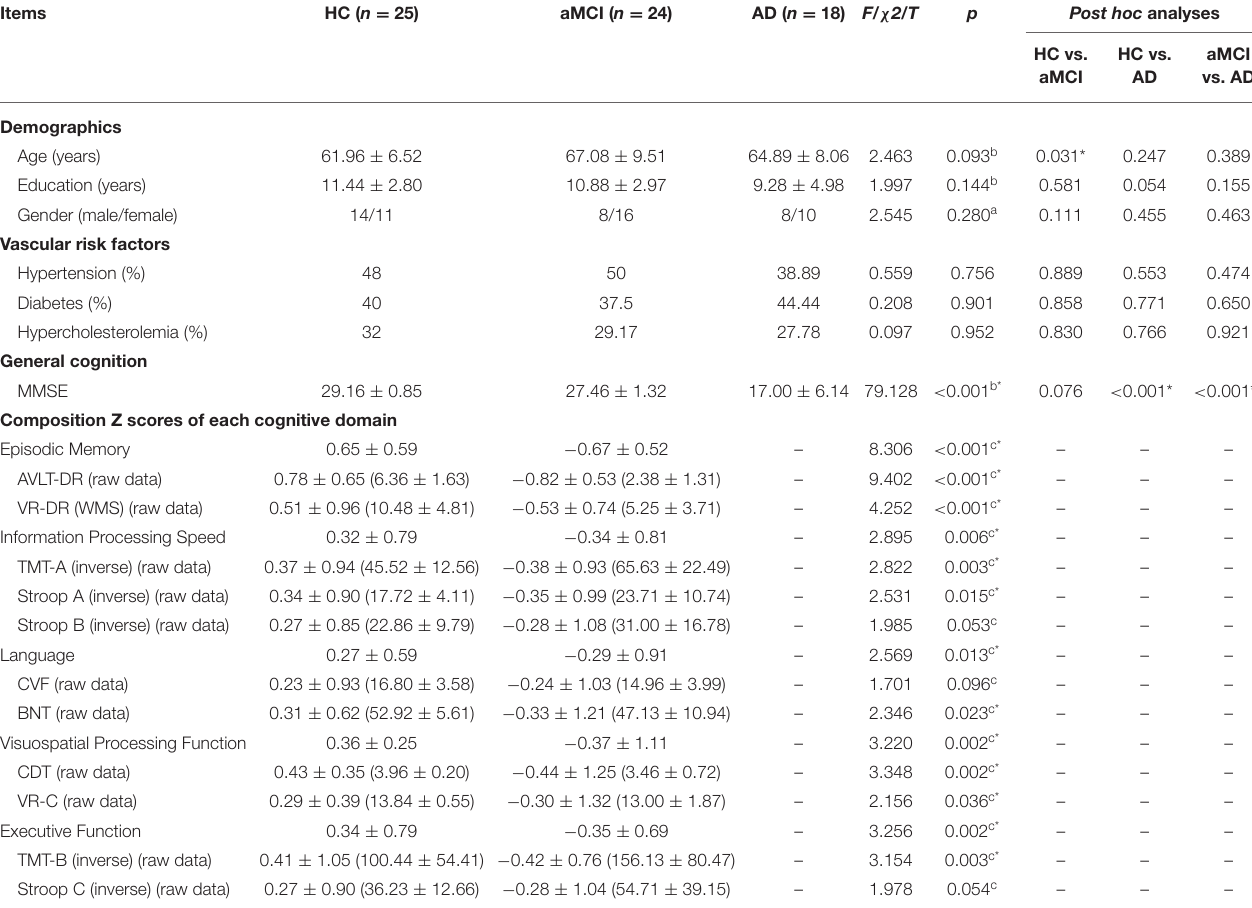
TABLE 1 | Demographic and neuropsychological